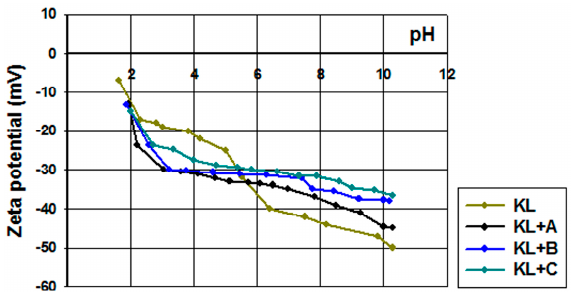
Figure 3. Zeta potential vs. pH for kraft lignin and activated lignins in selected ionic liquids: